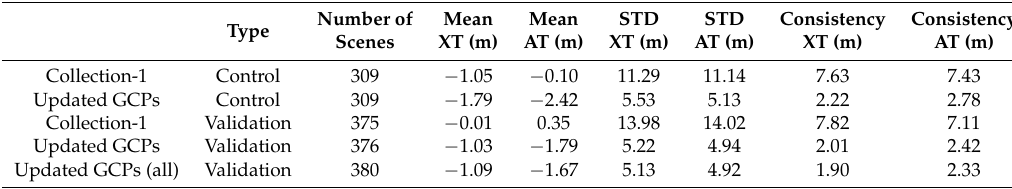
Table 11. Validation of the GCP updates using the geodetic accuracy validation procedure for the Eurasia